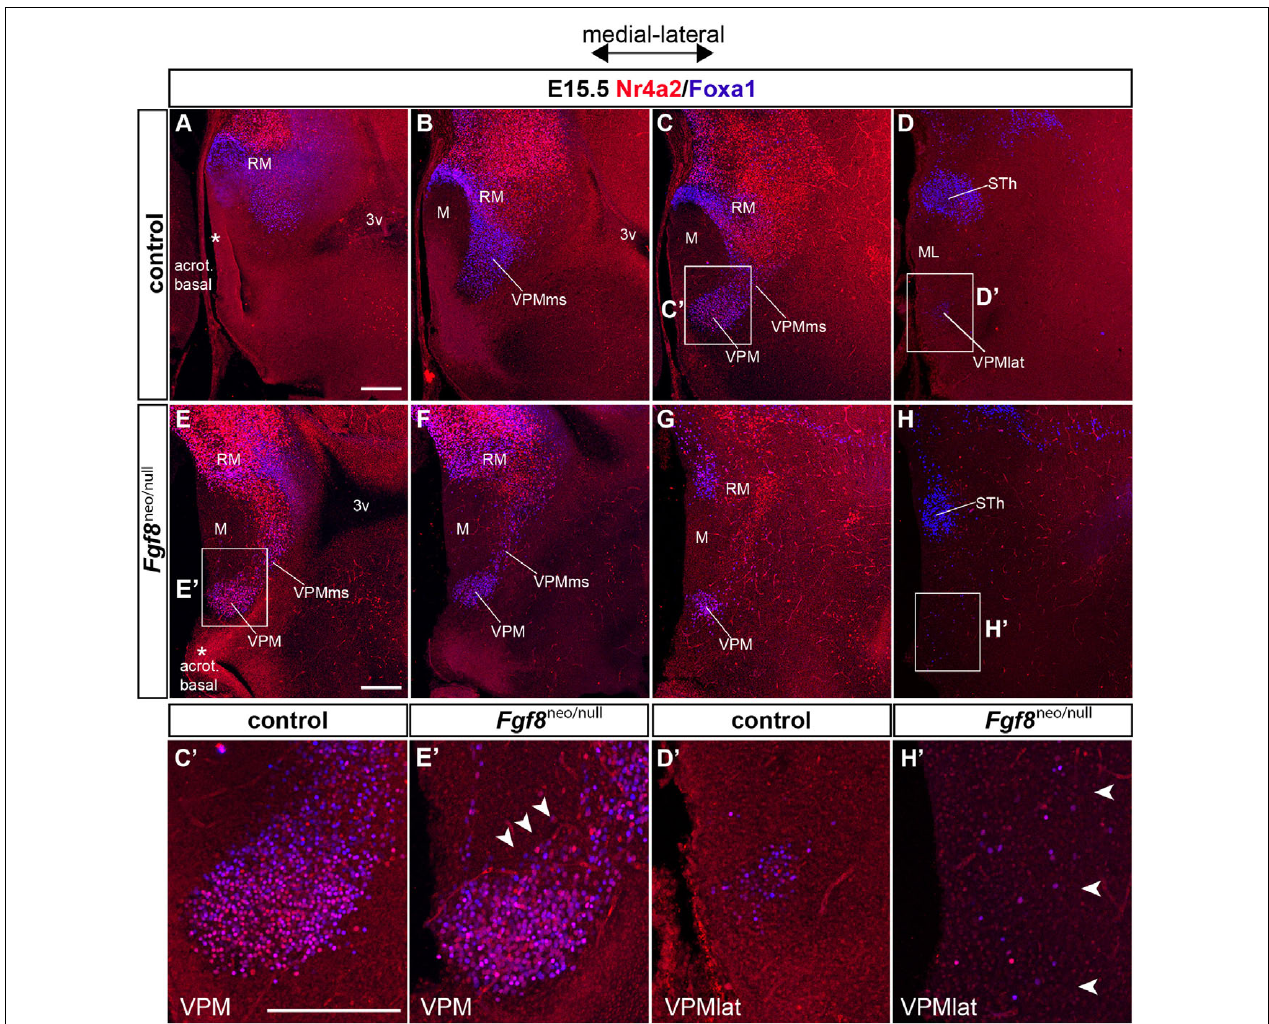
FIGURE 13 | Phenotype of Fgf8 severe hypomorph mice at E15.5. (A–D) Medio-lateral sagittal 50 µ m-thick sections of an E15.5 control embryo labeled with Foxa1 (blue) and Nr4a2 (red). (E–H) Medio-lateral sagittal 50 µ m-thick sections of a hypomorph Fgf8 neo / null E15.5 embryo labeled likewise with double Foxa1/Nr4a2 immunofluorescence. Note the hypomorph VPMms/VPM sections in (E–G) roughly correspond to wildtype VPM sections in (C) , suggesting that part of the hypomorph VPMms/VPM lies at abnormally medial positions. The lateralmost VPM cell population disappears earlier in the Fgf8 neo / null specimen compared with the wildtype. Moreover, the Foxa1-positive subthalamic nucleus (STh) is distinctly smaller in the hypomorph than in the wildtype specimen (compare STh in H versus D ). (C’,D’,E’,H’) Higher magnification comparison of wildtype and hypomorph pairs of images taken from the boxed-in areas in (C,D,E,H) . (E’) Apparently, the